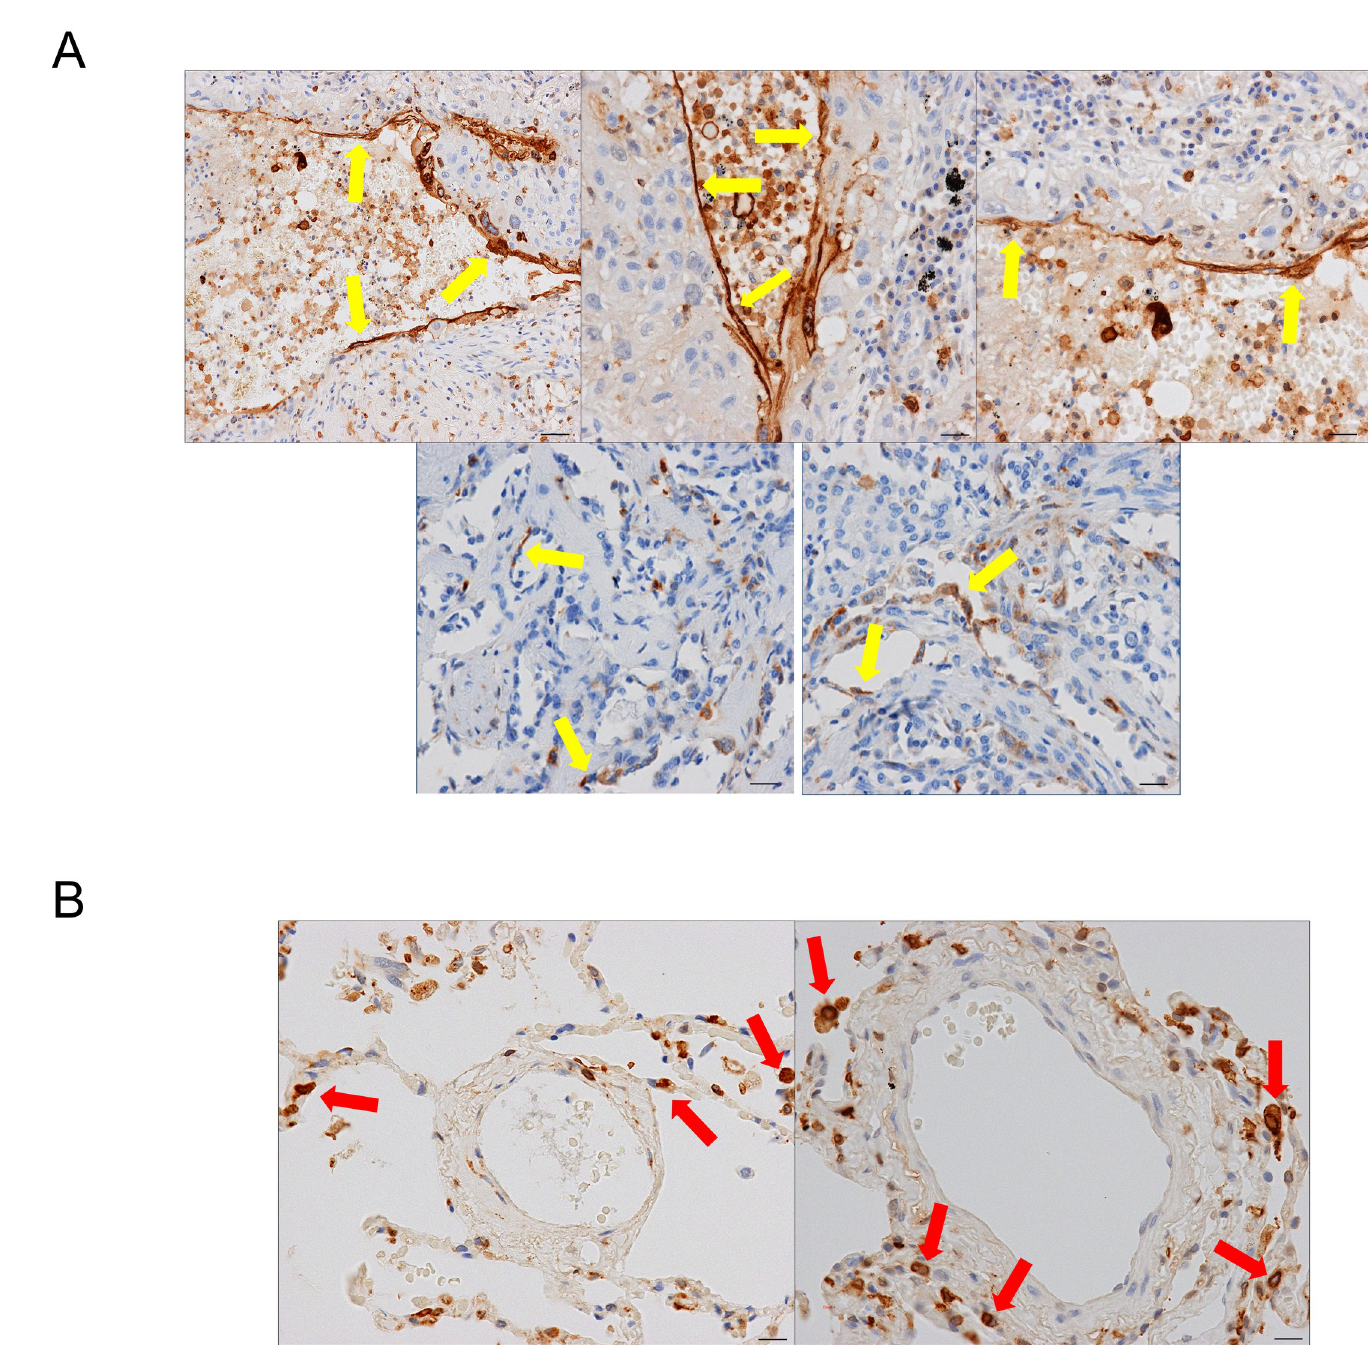
Fig 2. Vascular anxA1 IHC expression. Representative immunohistochemistry of human lung tumors (A) and normal lung (B) showing annexin A1 expression (brown) in the intratumoral vessels of human lung tumors, but not in the microvessels of normal lung. Vascular staining (yellow arrows) in 1–10% of total endothelial cells was observed in 5/8 human lung tumors (A), while positive staining of neoplastic cells was seen in 3/8 samples (not shown). In normal lung (B), no endothelial cell staining was observed in the 4 samples examined; however, interstitial and alveolar macrophages were strongly positive (red arrows). All scale bars = 10 μ m.